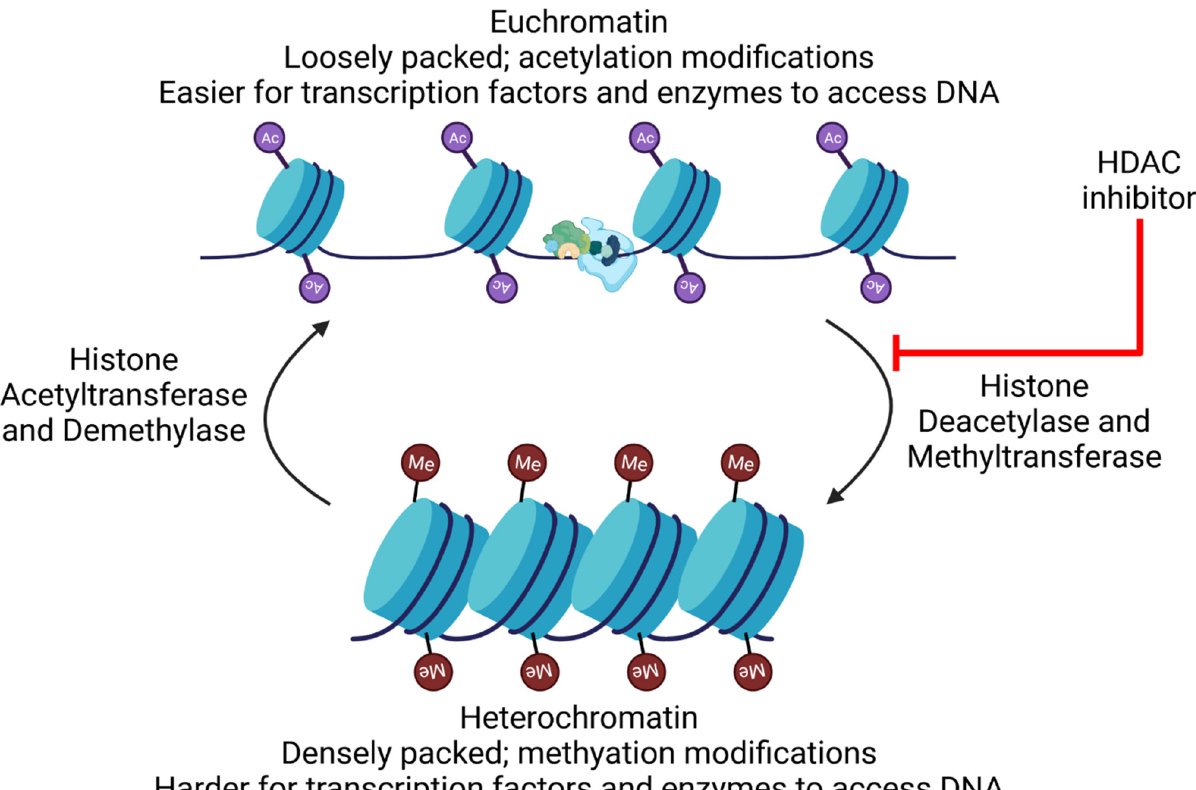
Figure 5. HDAC inhibitors drive chromatin towards a euchromatin state. The HIV LTR is associated with a closed, heterochromatin state suppressing viral transcription by being physically difficult to access. By inhibiting the deacetylation of the histones, this changes the charges associated with the histones and provides a looser conformation such that transcription factors and RNA Polymerase II are better able to access the DNA.